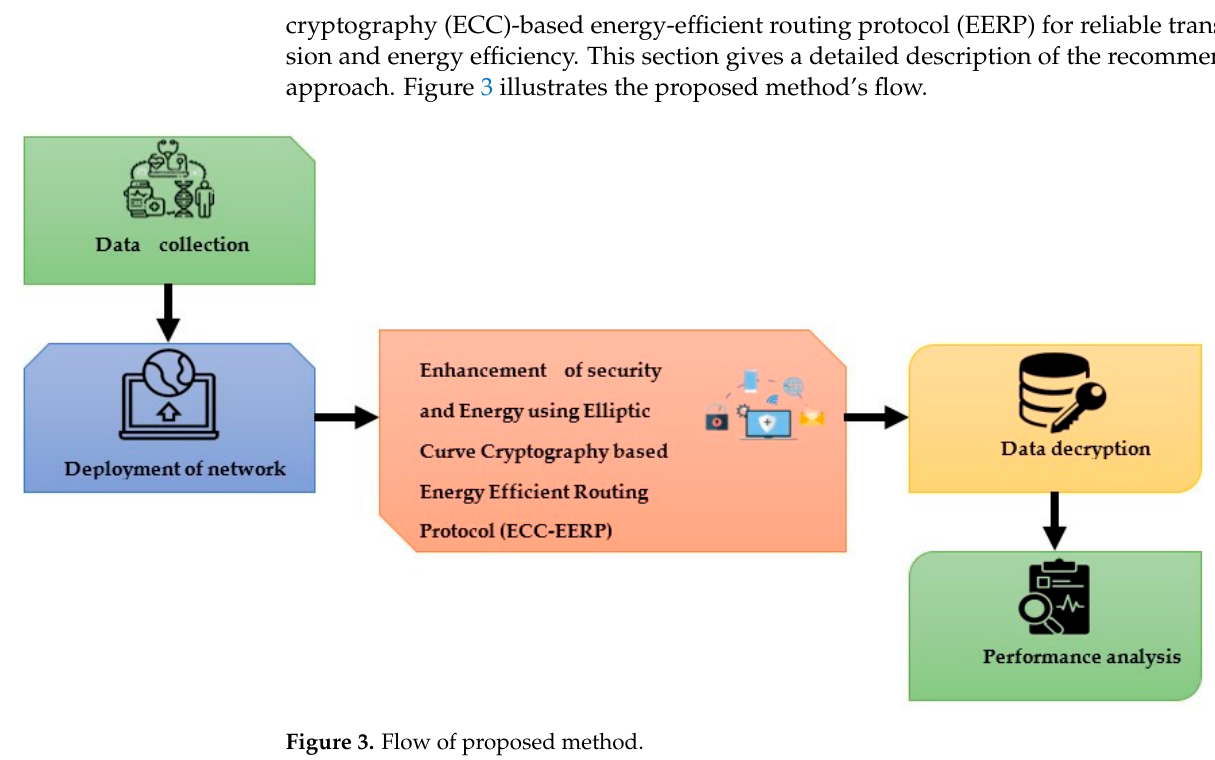
Figure 3. Flow of proposed method .